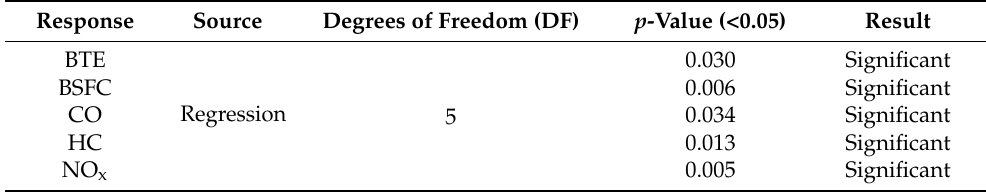
Table 9. ANOVA for predicted mathematical model of the response.